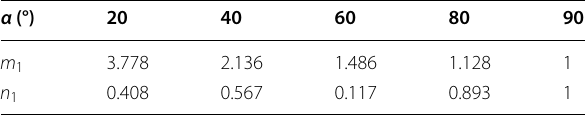
Table 1 Values of ( m 1 & n 1 ) versus the angle of contact (α ◦